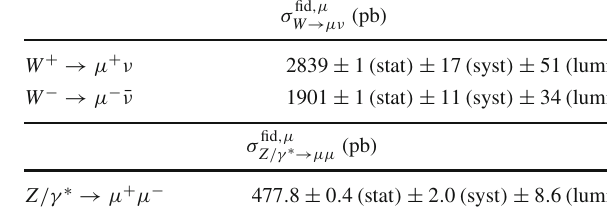
mated yield of multijet events. The sum of all expected background and signal contributions is shown as a solid line with a hashed band detail- ing the statistical uncertainty and labelled “total (stat)”. The legend lists only background sources with a visible